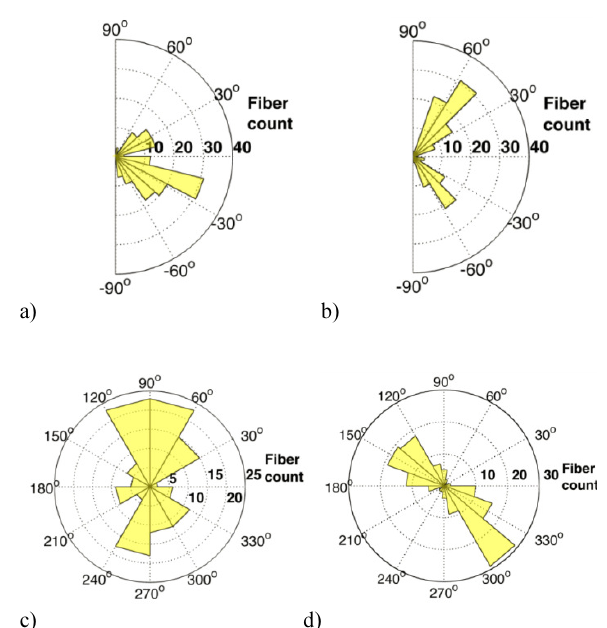
Fig. 11. Distributions of Phi (a, b) and Theta (c, d) angles for fibre orientations in specimens cut from the top zone (a, c) and the bottom zone (b,